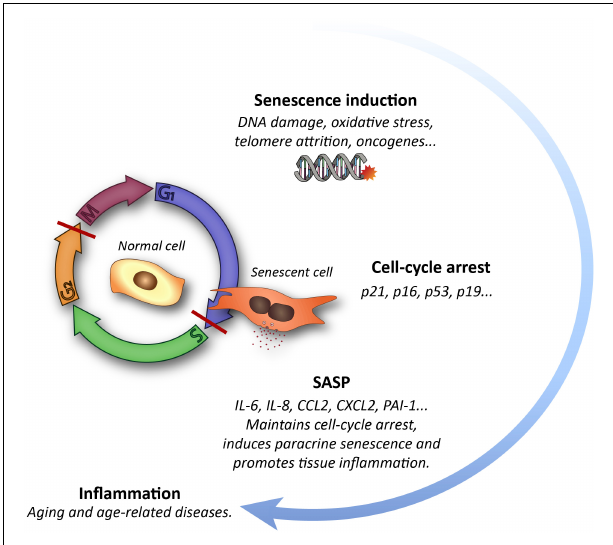
FIGURE 1 | Schematic representation of the cellular senescence process and its impact on